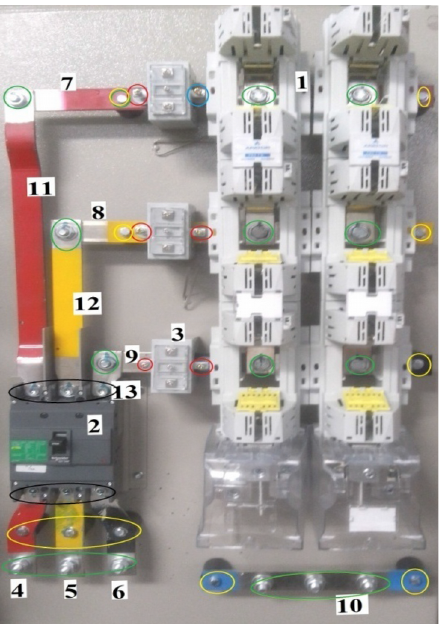
Figure 6. PHB-TR 252 Electrical